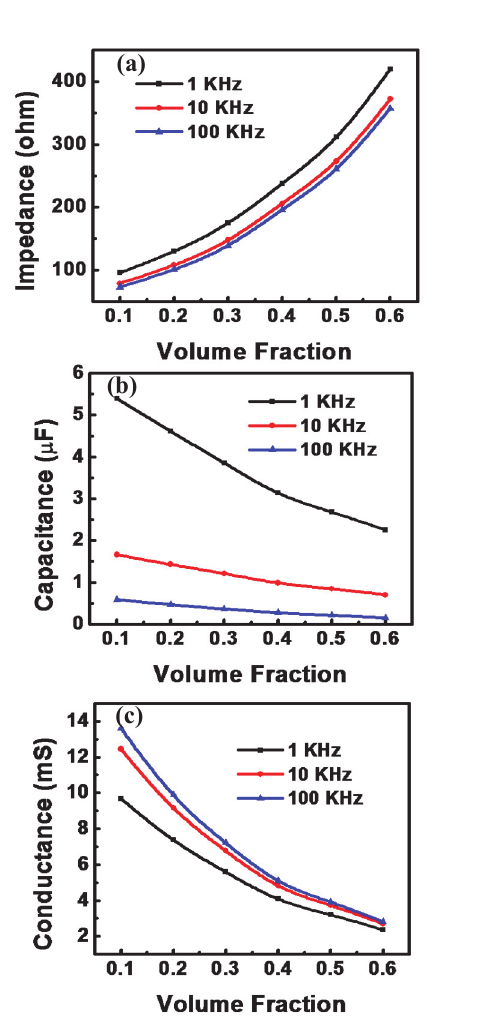
Fig. 4: Plots of the variations of electrical parameters with volume fraction of glucose in PBS: (a) variation of impedance 1 kHz, 10 kHz and 100 kHz; (b) variation of capacitance at frequencies 1 kHz, 10 kHz and 100 kHz and; (c) variation of conductance at 1 kHz, 10 kHz and 100